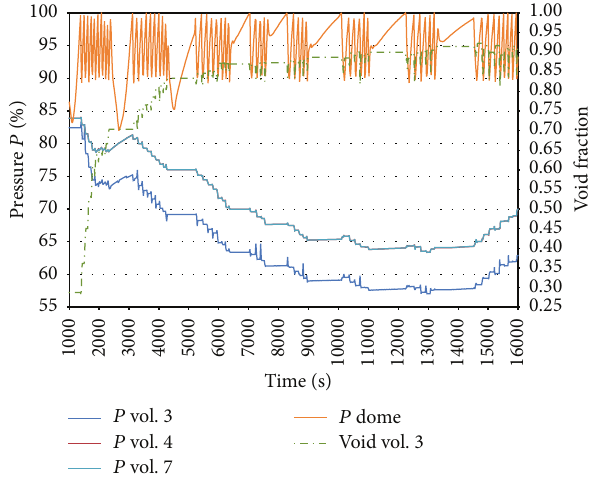
Figure 9: Pressure and void fraction evolution in containment during ECCS injection